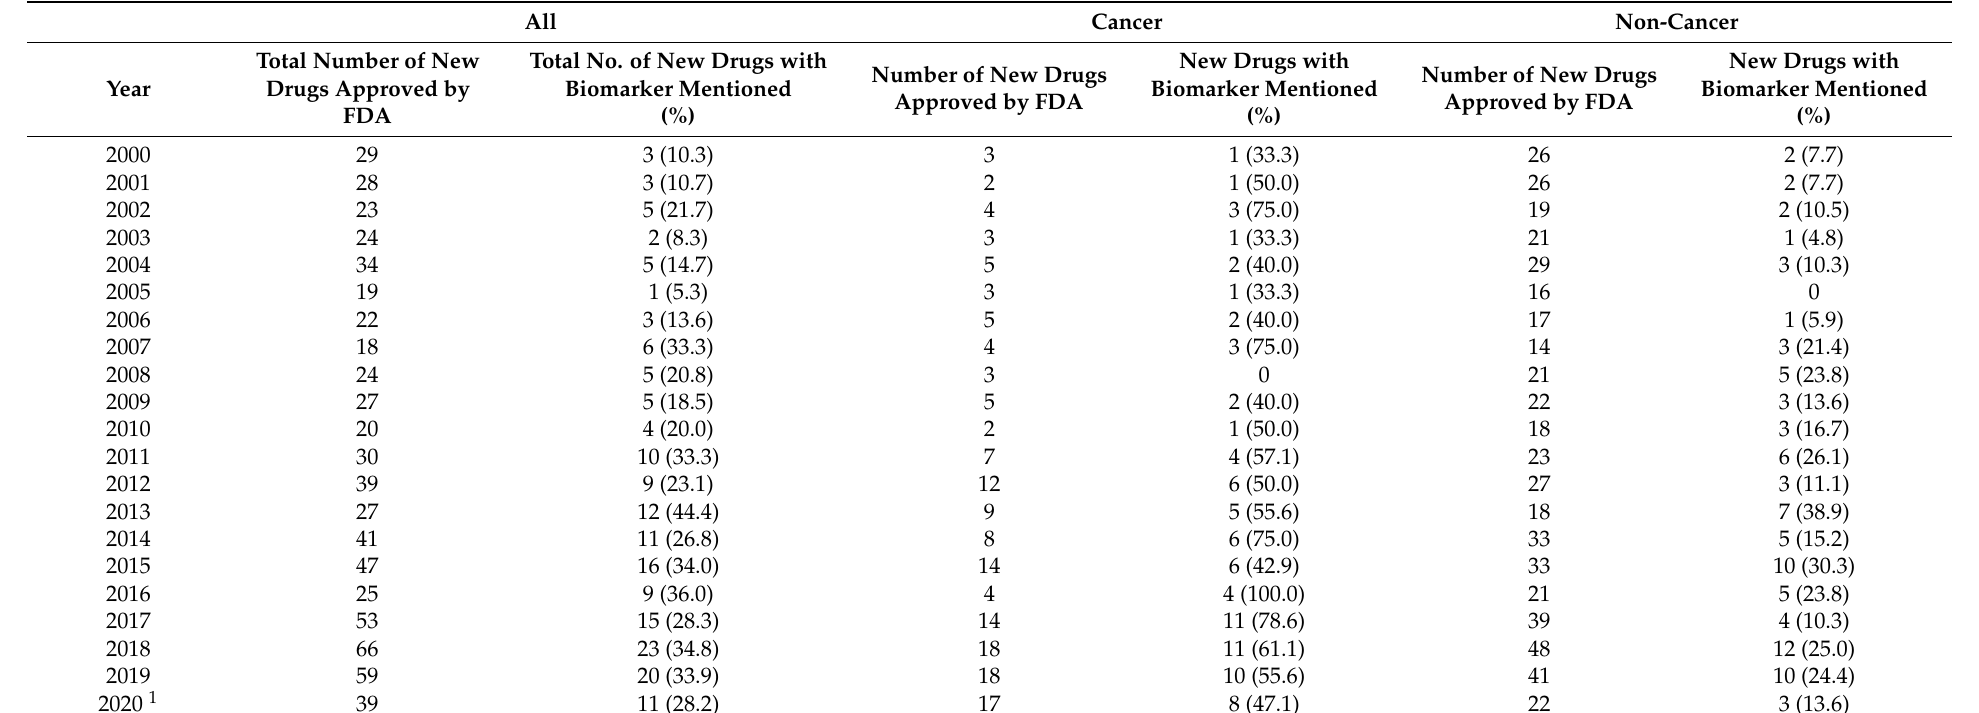
Table 1. Annual proportion of drug approvals with PGx labeling for cancer vs. non-cancer indications. All Cancer